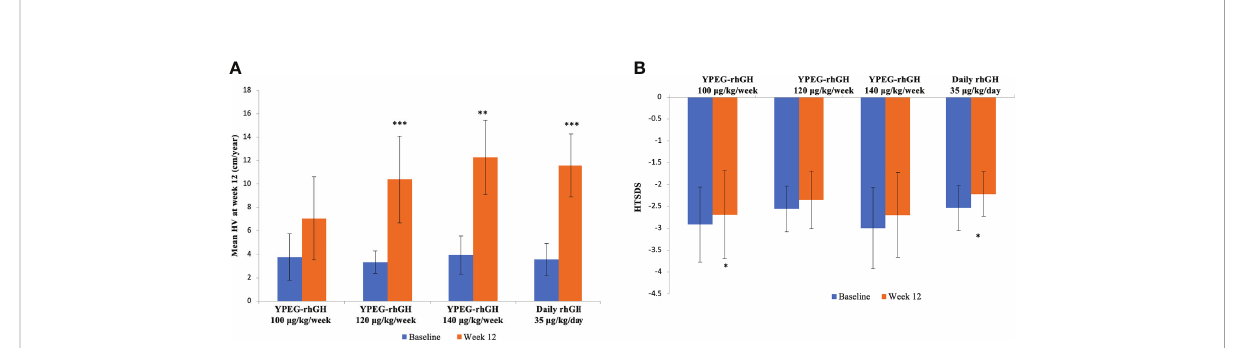
FIGURE 4 HV and HTSDS before and after the treatments. (A) , Mean HV at baseline and Week 12. (B) , HTSDS at baseline and Week 12. Data are shown as mean ± SD. * p < 0.05, ** p < 0.01, *** p < 0.001.